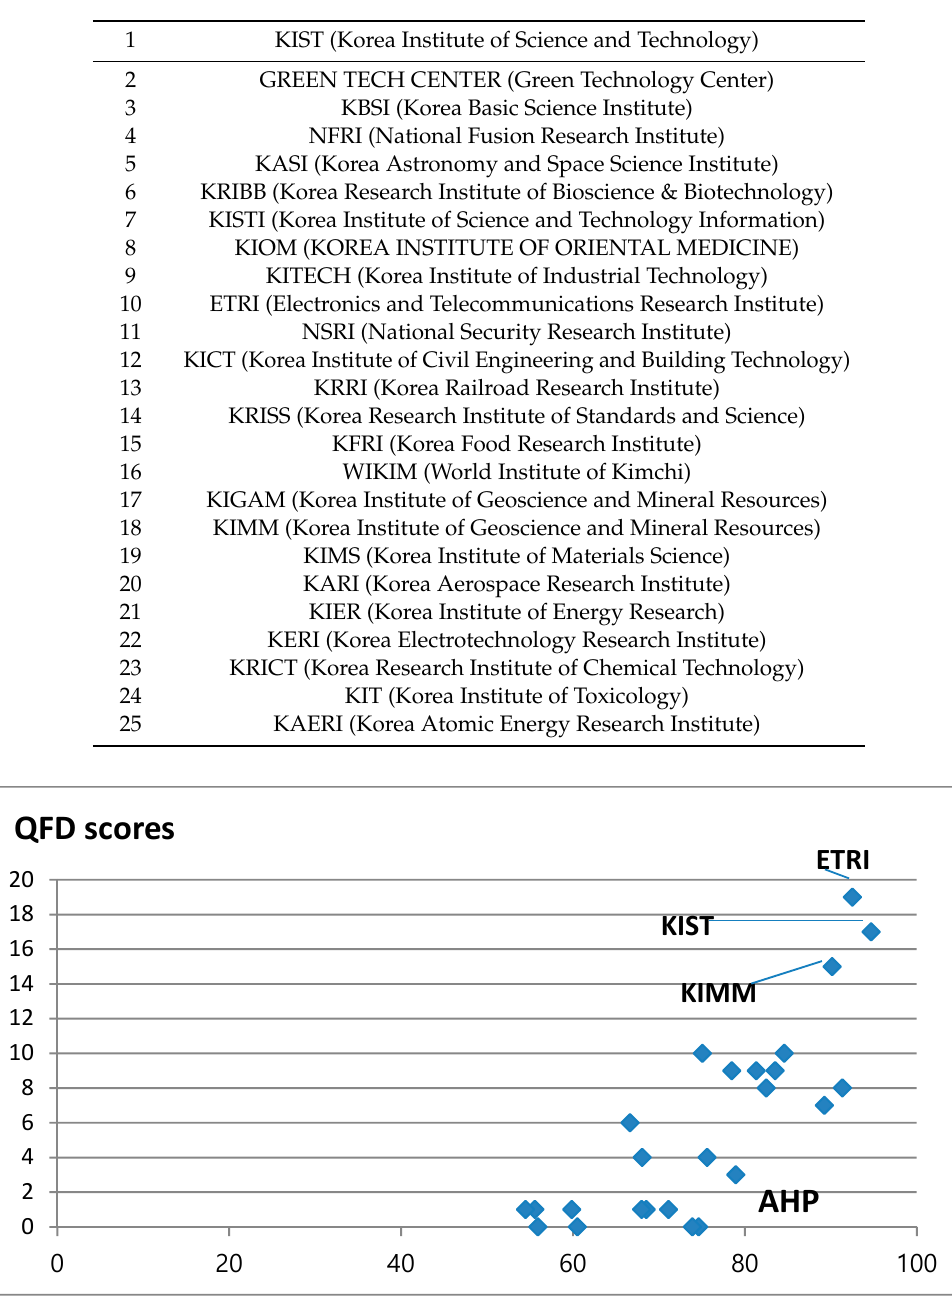
Table 7. Index of research institutions.